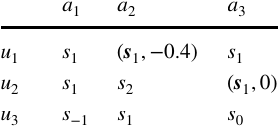
Table 4 IFLC ( U , A , { S , ⋄ } , R ⋄